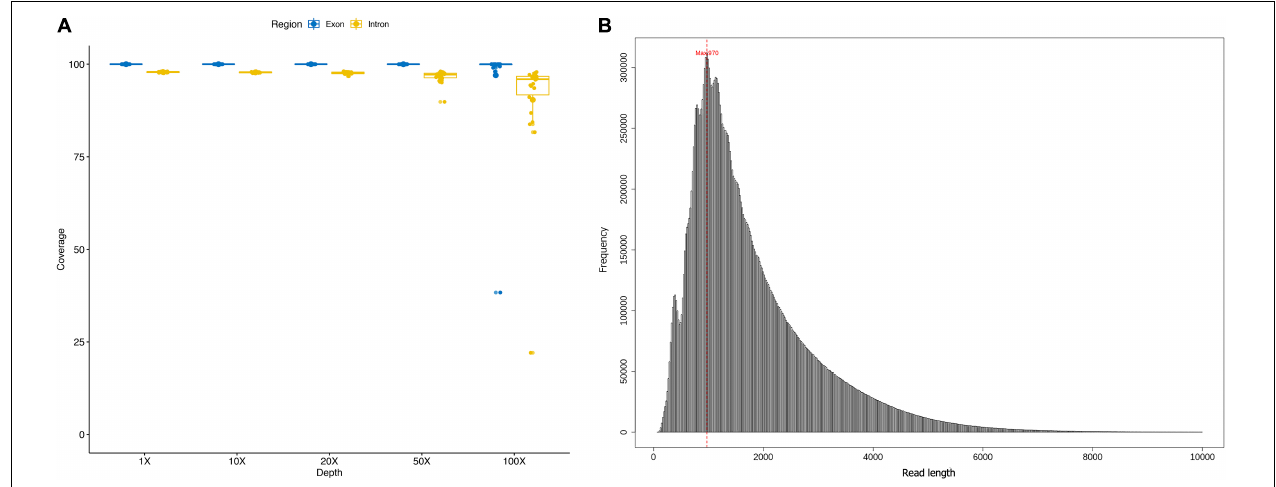
FIGURE 1 | (A) Coverage ratio in different depth level of each sample; (B) the length of sequencing reads of each sample.